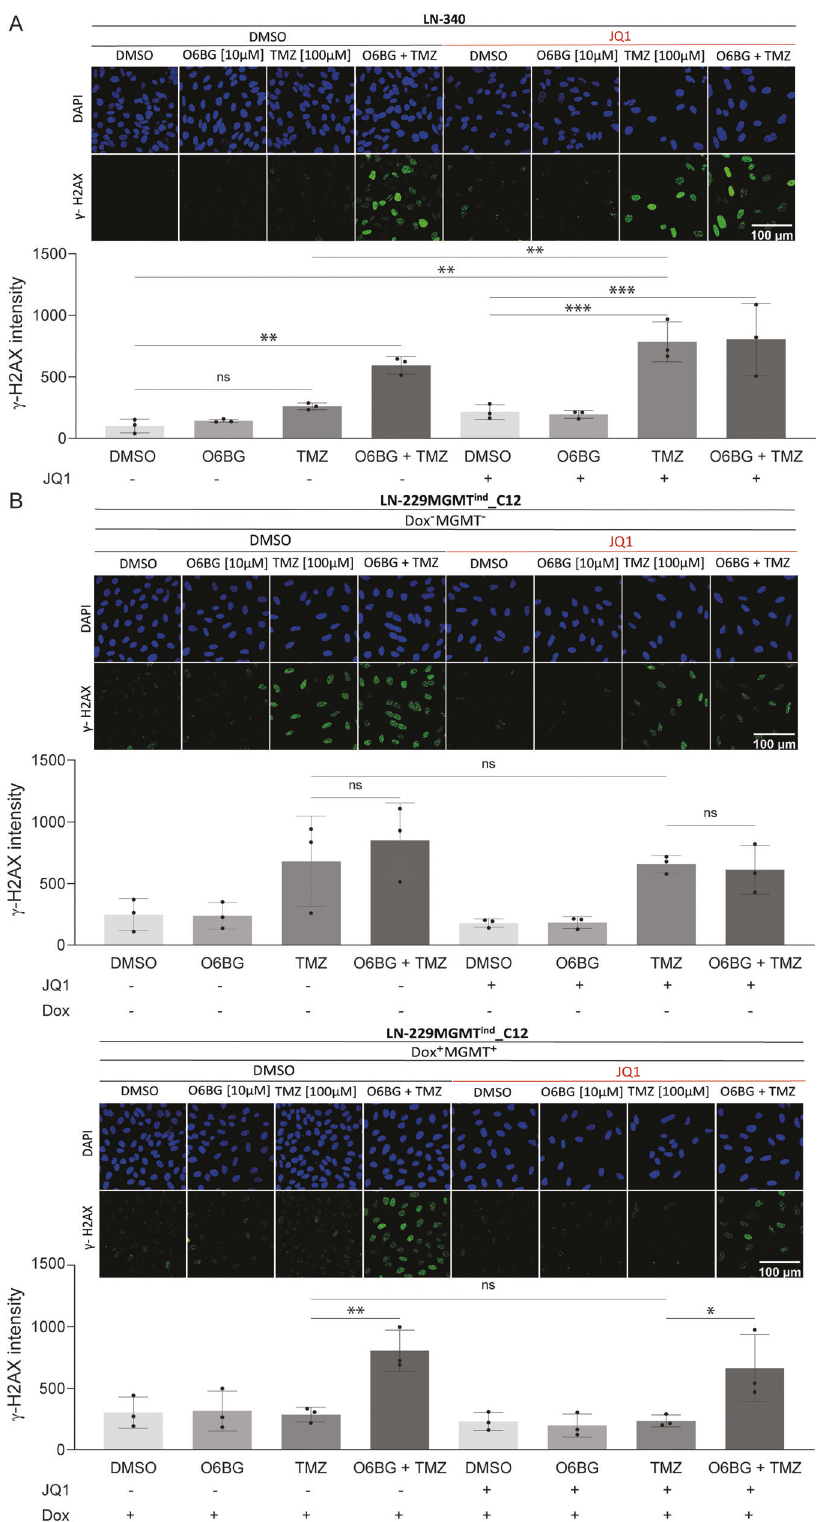
Fig. 4 JQ1 modulates repair of TMZ-induced DNA damage. A Mean γ -H2AX integrated intensity analysis was performed on LN-340 cells using immuno fl uorescence (IF). Cells were pretreated with JQ1 [0.250 µM] for 5 days. On day 5, cells were treated with O6BG [10 µM] together with TMZ [100 µM]. Two additional TMZ treatments were given every 6 h, for a total of 3 TMZ treatments on day 5. End-point was set at 48 h after TMZ treatments. Data represent the mean from three independent biological experiments. The adjusted p -values were provided by Dunnett T3 multiple comparisons tests following one-way ANOVA. *( p ≤ 0.05), **( p ≤ 0.01), ***( P ≤ 0.001). Error bars are SD. B Cells of GBM line LN-229MGMT ind _C12 were treated according to the same schedule as in ( A ), but at a lower JQ1 concentration [100 nM]. The experiments were performed in absence and presence of doxycycline [100 ng/ml] (Dox), respectively. Dox treatment induces ectopic expression of MGMT under the control of the Tet-ON promoter. Scale bar 100 μ m. Cell Death and Disease (2022)